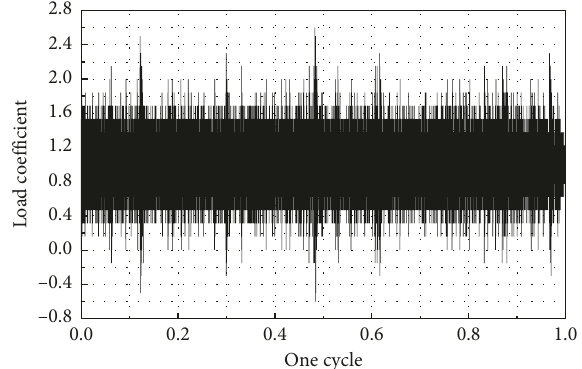
Figure 6: Mini-Twist loading diagram.